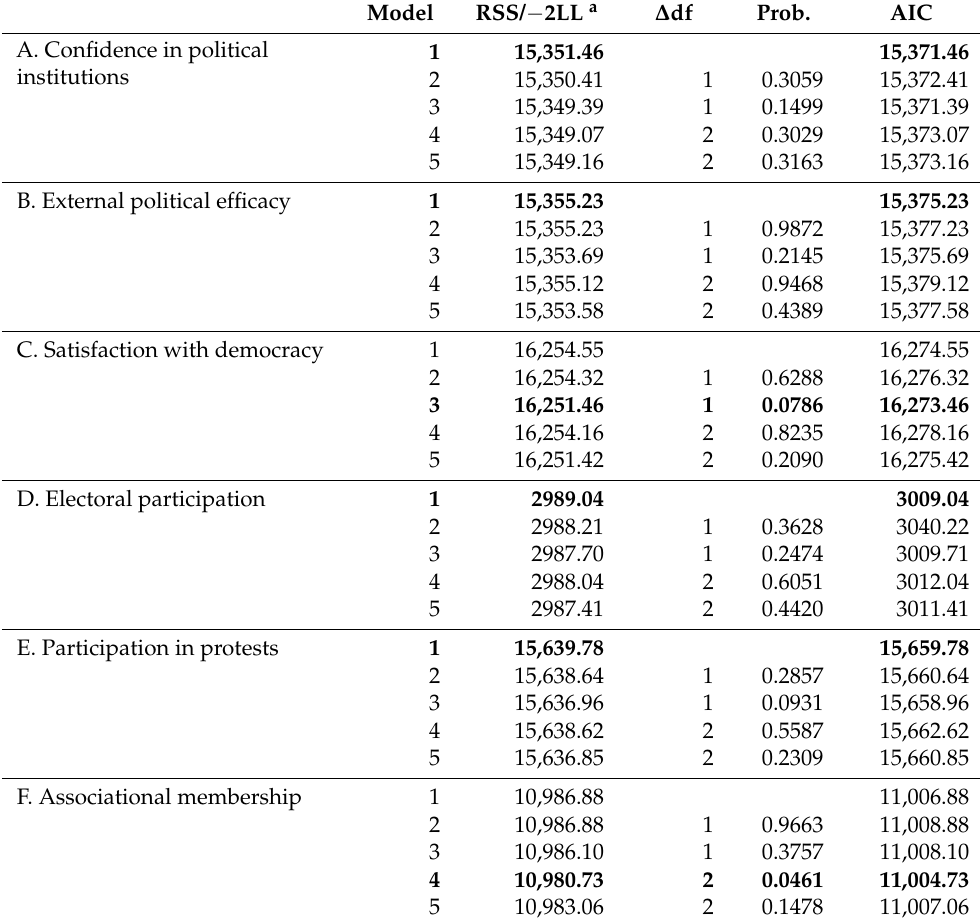
Table 1. DRM models assuming homogeneous effects of overeducation on attitudes towards the political system and political participation. Goodness-of-fit